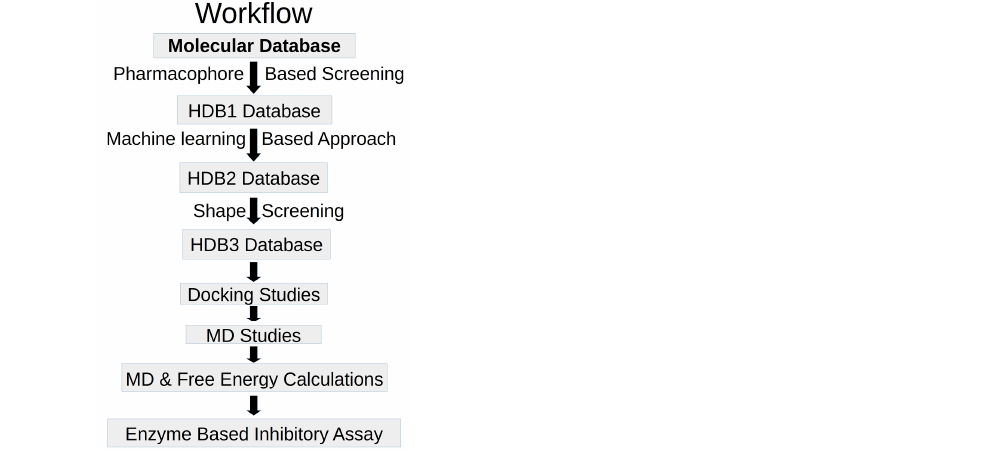
Figure 1. Work fl ow employed for identifying the potent ligands against MAO-B protein using Figure 1. Workflow employed for identifying the potent ligands against MAO-B protein using various various computational approaches. computational